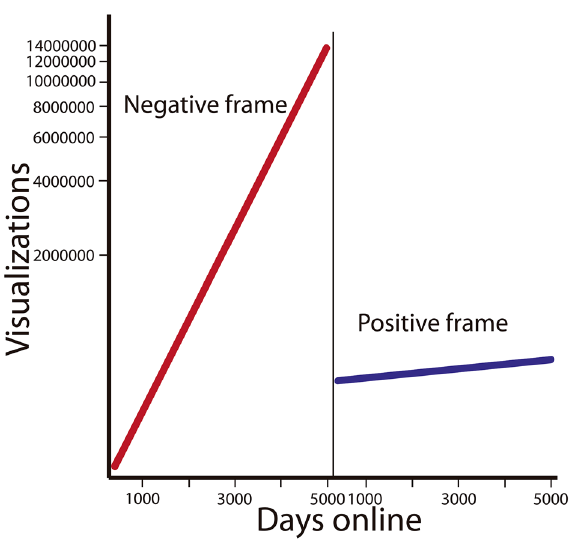
Figure 2. Predicted number of views of videos on vultures with negative or positive framing (see Fig. 3) in relation to the days since they were uploaded onto YouTube (based on a GLM with Poisson distribution, see